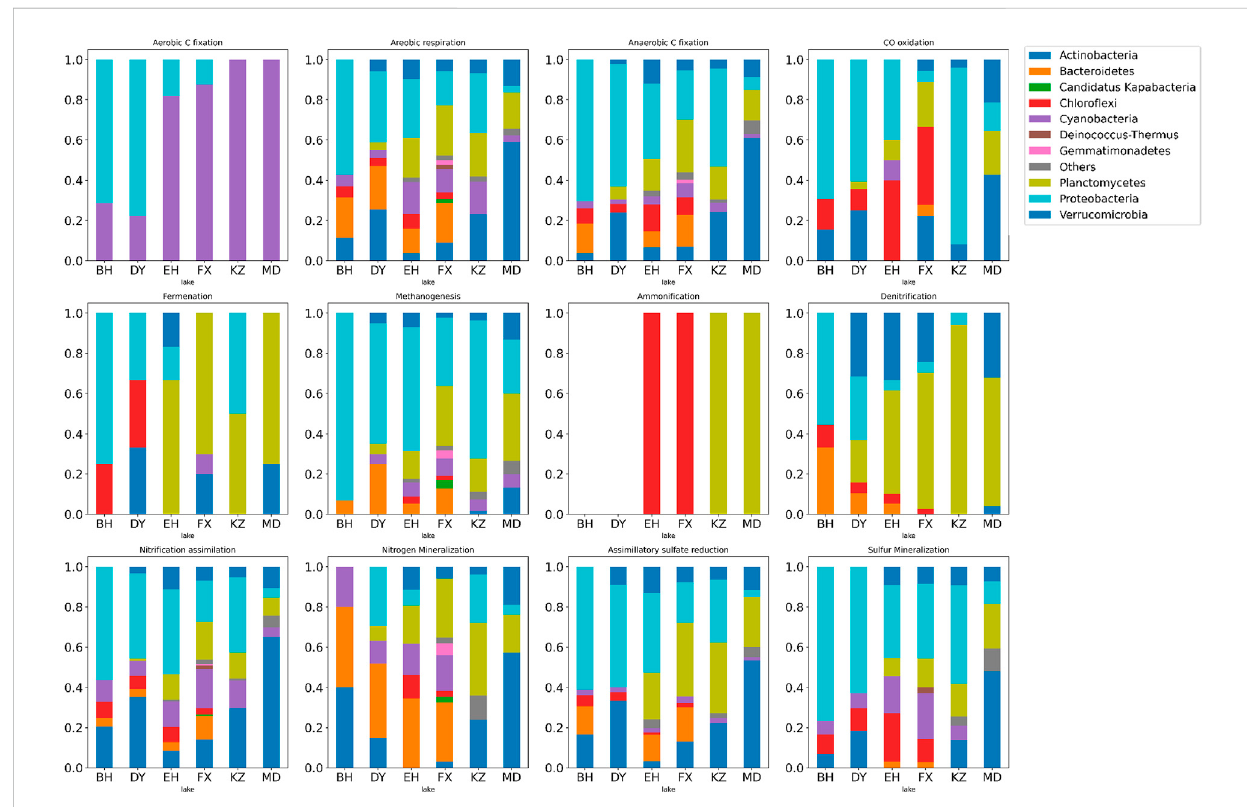
FIGURE 5 Stacked histogram of relative abundance of microbial functions in six typical lakes during 12 metabolic processes of nitrogen, and sulfur cycles. The horizontal axis represents each lake, the vertical axis represents the percentage of relative abundance of functions and the color represents phylum.